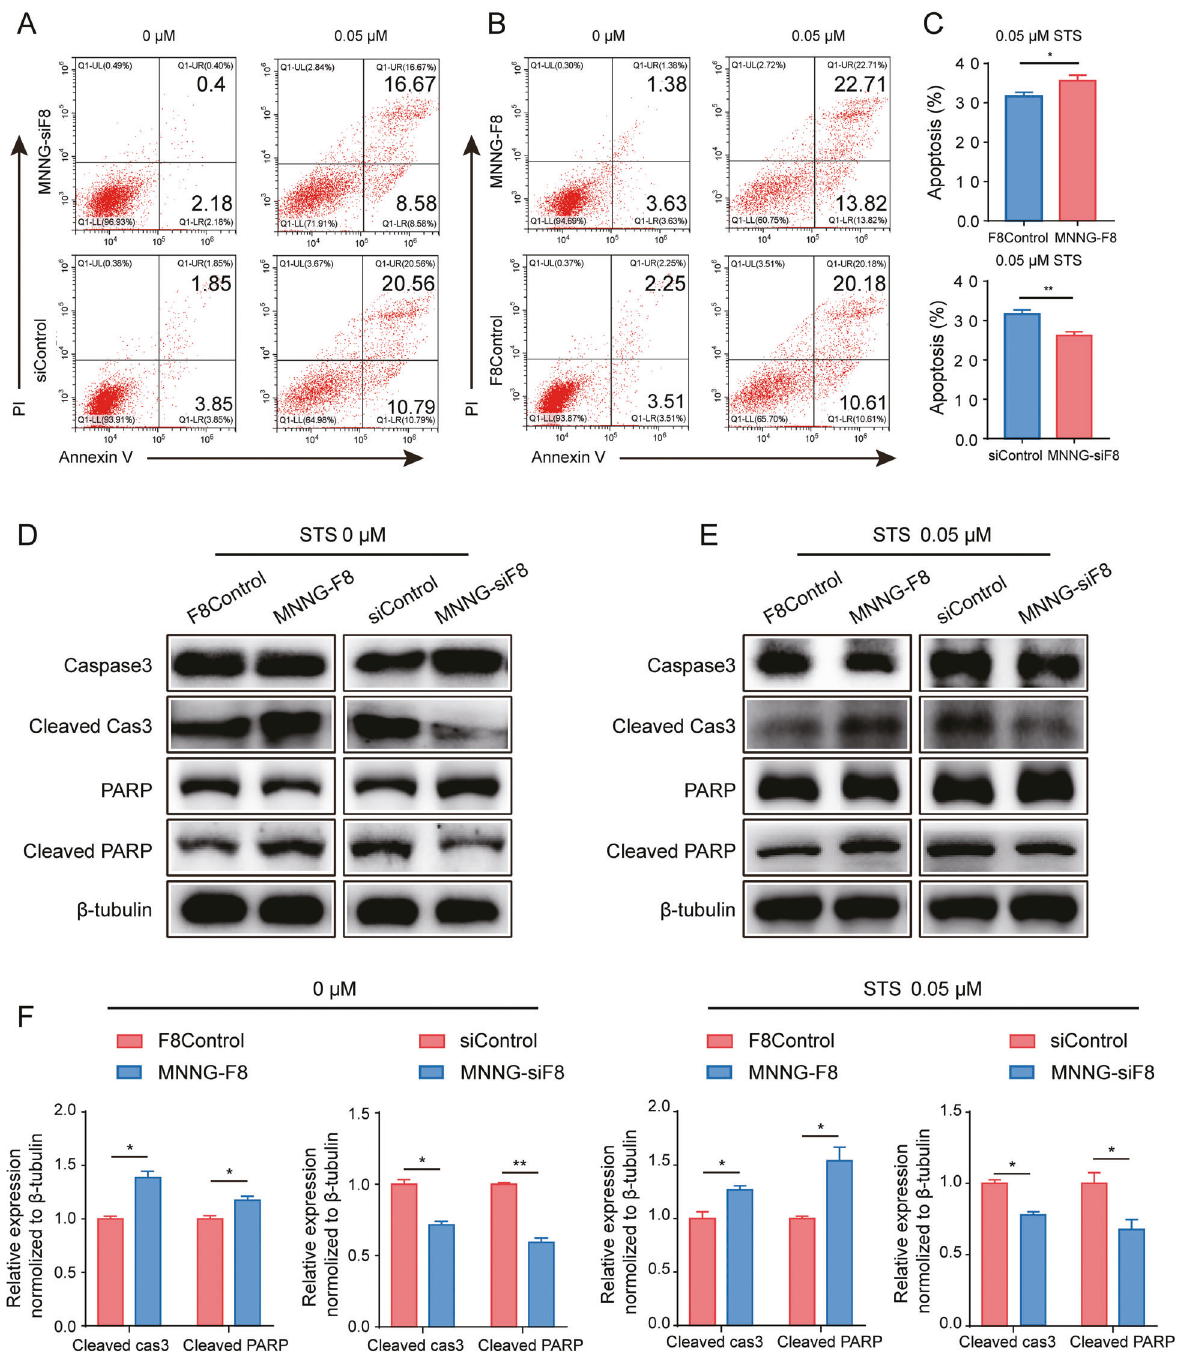
Fig. 3 Expression of FUT8 is positively correlated with the apoptotic rate of OS cells. A , B Two-label dot plots of fl ow cytometry analysis of two FUT8-regulated OS cell lines (MNNG-F8, MNNG-siF8) and their control cell lines (F8Control, siControl, respectively) treated with either 0 μ M or 0.05 μ M STS for 24 h. Cells were stained with Annexin V/PI. Compared to control cells, in MNNG-F8 and MNNG-siF8, apoptosis was enhanced and reduced, respectively. C Quantitation of fl ow cytometry analysis, data were shown as mean ± SD ( N = 3). D , E Western blot probed with antibodies against apoptosis-related proteins in the four cell lines with or without 0.05 μ M STS treatment con fi rmed that, compared to control cells, cleaved-caspase 3 and cleaved-PARP were more or less abundantly expressed, respectively, in MNNG-F8 and MNNG- siF8 cells. F Quantitative expression values of the WB results in D and E were normalized to β -tubulin expression ( N = 3). * P < 0.05; ** P < 0.01. p52 into the nucleus. However, the aggregation of p52 in the method we used for detecting the relative core-fucosylation level nucleus was inhibited by FUT8 overexpression (Fig. 6D, E). of TNFR in F8Control cells, MNNG-F8 cells, siControl cells, and MNNG-siF8 cells. In particular, we enriched TNFR from the four OS cell lines by immunoprecipitation and detected expression of Lack of core fucosylation of TNFR shifts TNF signaling TNFR. The core-fucosylation level of TNFR was detected by lectin We were also interested in examining possible changes in blot. The level of TNFR core fucosylation was reduced in FUT8- signaling upstream of NF- κ B2. Figure 7A shows a diagram of the Cell Death and Disease (2021)